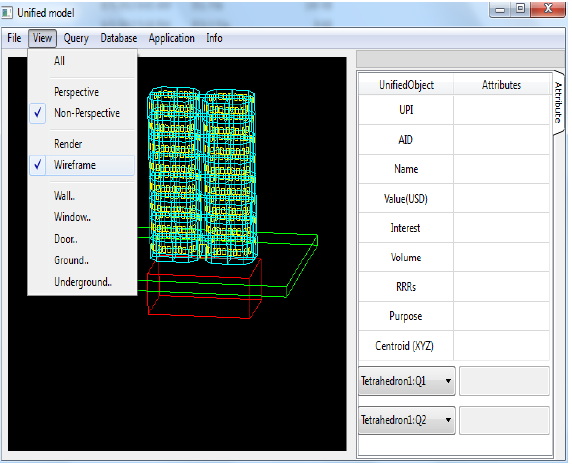
Figure 6. Tetrahedral mesh for a building block degenerated to simplified unified